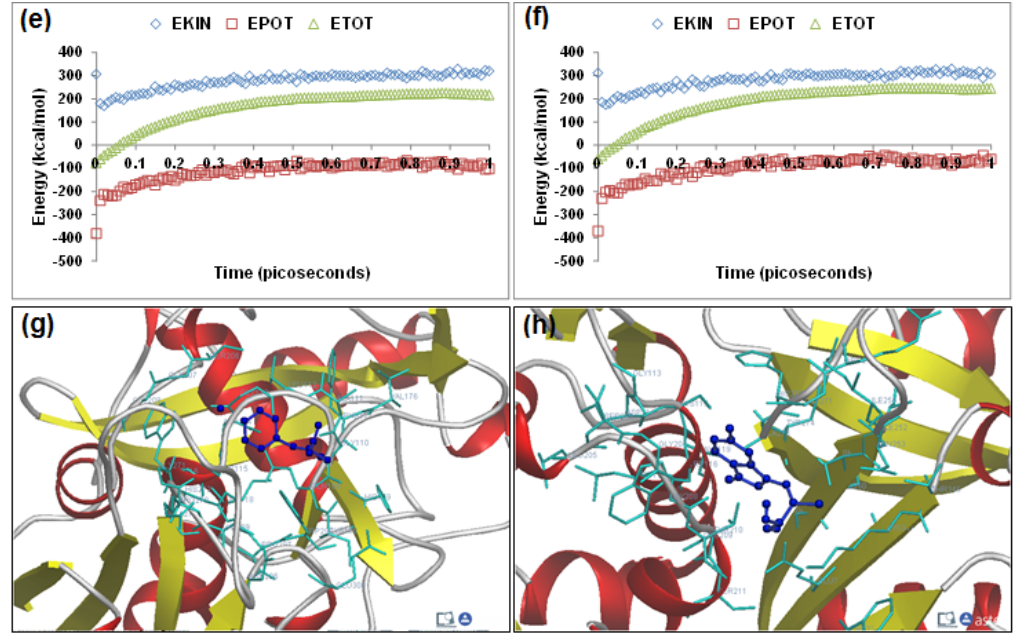
Figure 5. Visualization of the geometrical preferences of the calpain molecule (green secondary structure) in complexation with ligand molecules (yellow tube rendering), ( a ) PD150606 and ( b ) PD151746 after molecular mechanics simulations. 3D-mapped isosurface plot representing the electrostatic potential for ( c ) calpain–PD150606 and ( d ) calpain–PD151746. The kinetic energy (EKIN), potential energy (EPOT), and total energy (ETOT) values for ( e ) calpain–PD150606 and ( f ) calpain–PD151746 calculated by molecular dynamic simulations in vacuum. The most favorable poses of ( g ) PD150606 and ( h ) PD151746 within calpain were obtained via molecular